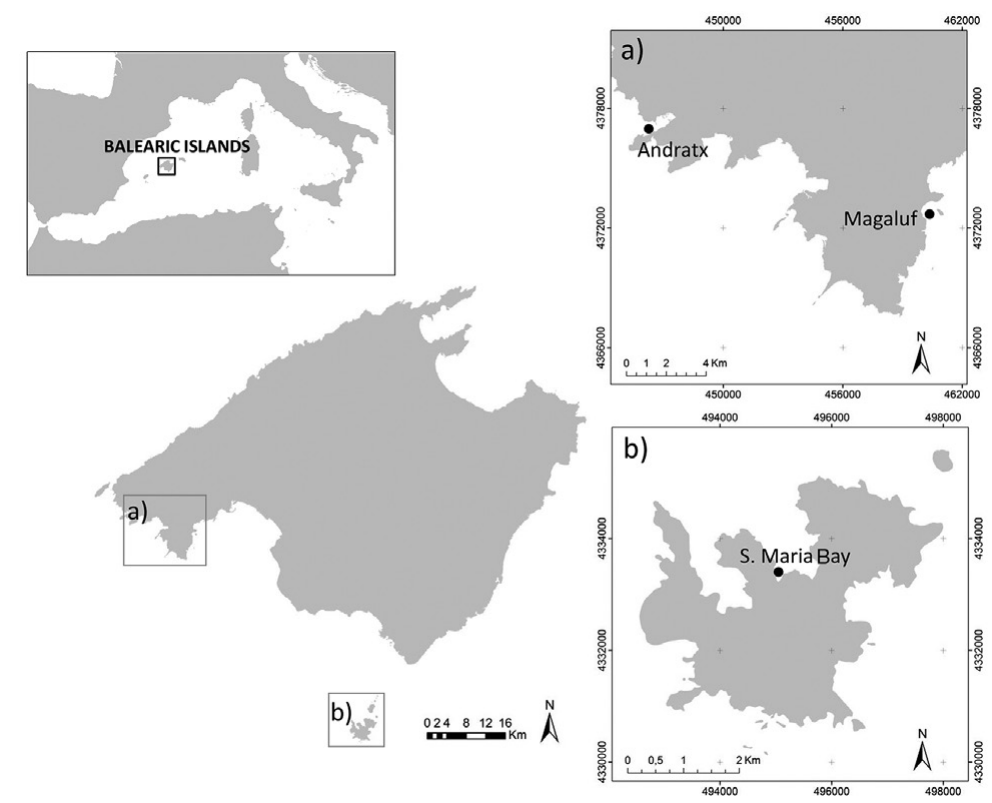
Fig. 1. – Location of the collection sites: a) Andratx (harbour) and Magaluf (coastal town) on Mallorca Island, and b) Santa Maria Bay in the Cabrera Marine-Terrestrial National